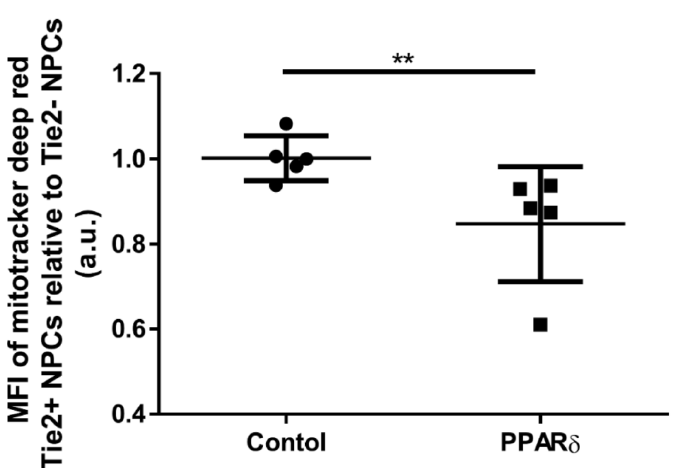
Figure 5. Plot of individual values and median of fluorescence intensities (MFIs) of mitochondria mass in Tie2+ NPCs relative to Tie2- NPCs measured, using mitotracker™ deep red and flow cytometry. “Control” represents cells cultured with control media without PPAR δ agonist, “PPAR δ ” refers to cells cultured with PPAR δ agonist treatment; “a.u.” refers to arbitrary units. Mann–Whitney U test, p = 0.0079; ** p -value < 0.01. Lines represent means ± SD; n = 5